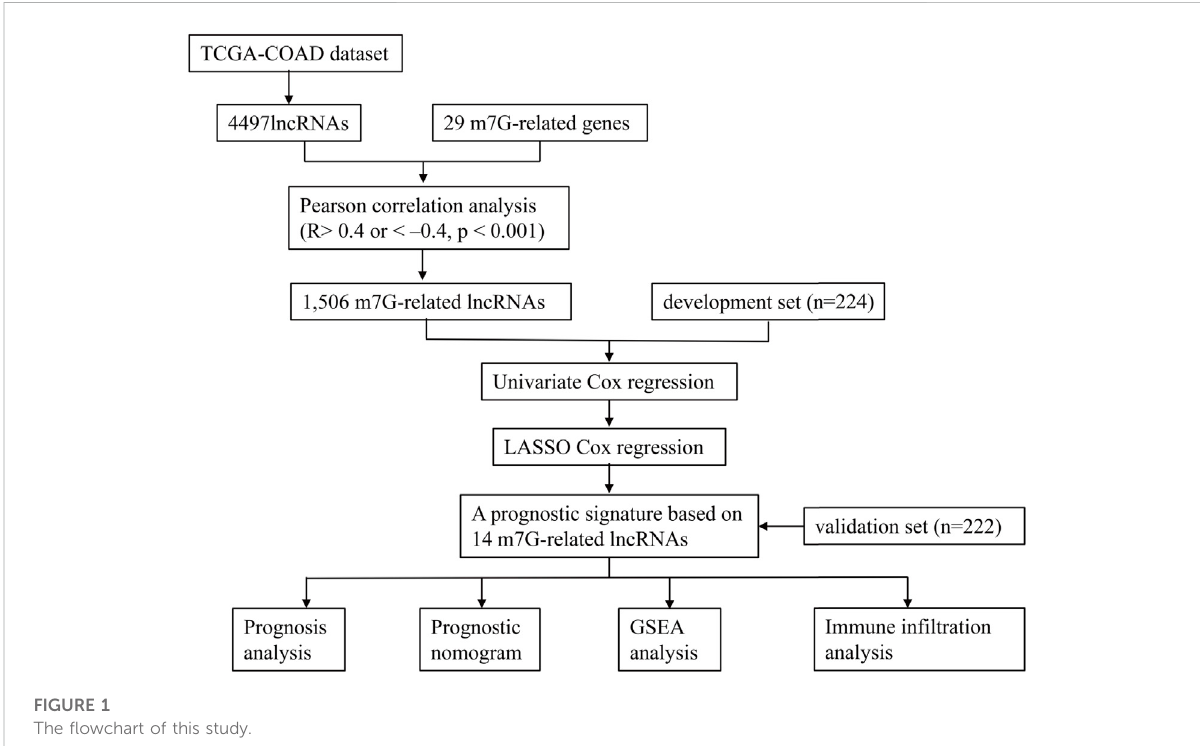
FIGURE 1 The fl owchart of this study.